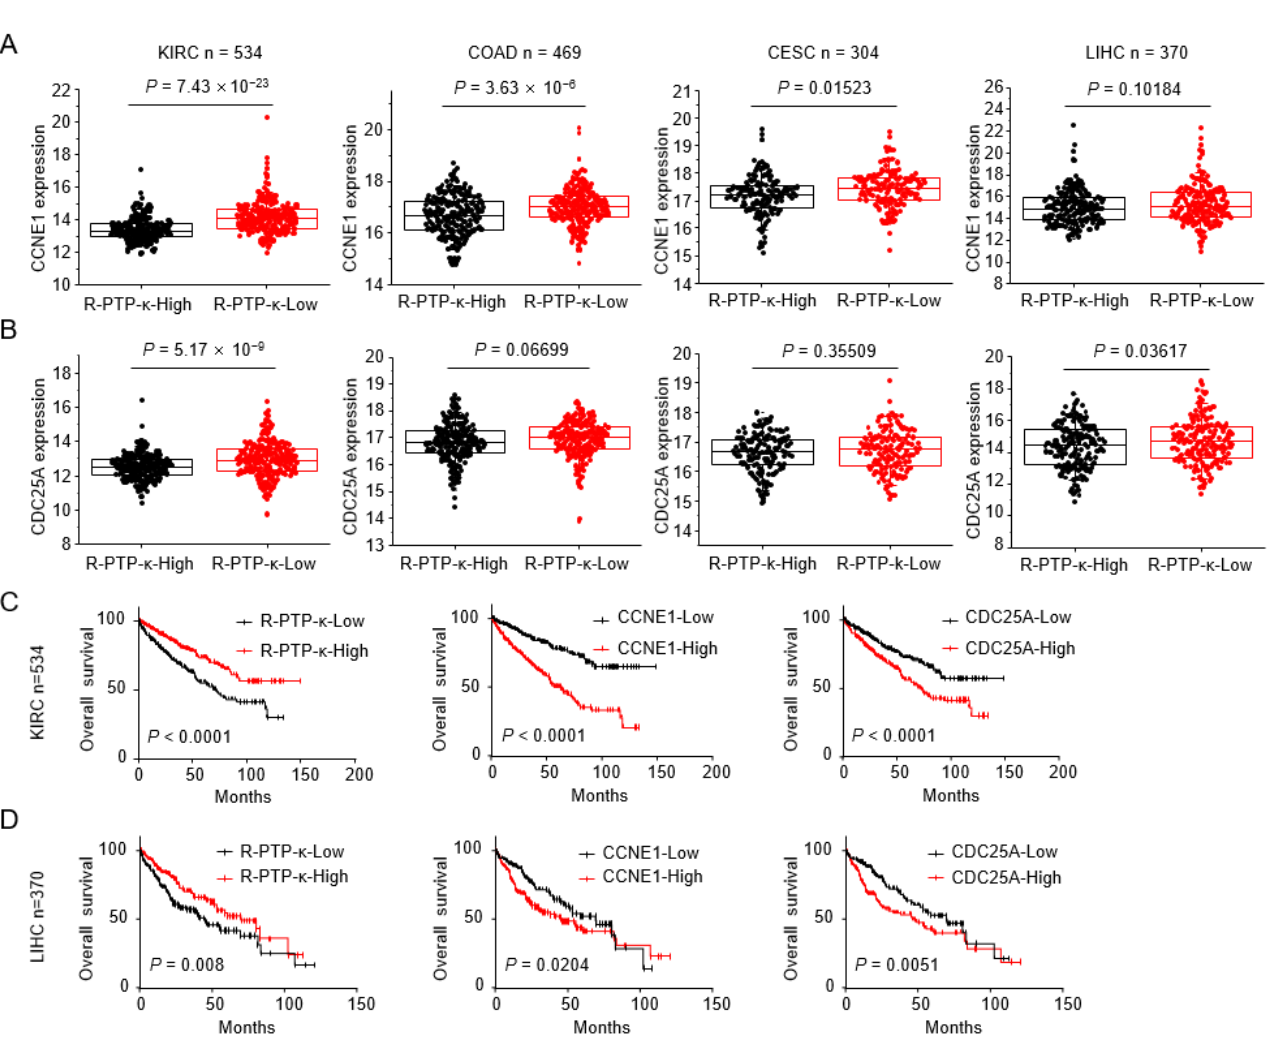
Figure 5. Analysis of expression correlation between R-PTP- κ and two E2F1 target genes, CCNE1 and CDC25A . ( A ) Expression pattern analysis of R-PTP- κ and CCNE1 in the public datasets generated from four different tumor types. ( B ) Expression pattern analysis of R-PTP- κ and CDC25A in the public datasets generated from four different tumor types. ( C ) Kaplan–Meier curve for overall survival in the KIRC cohorts according to relative expression of R-PTP- κ or the two E2F1 target genes. ( D ) Kaplan–Meier curve for overall survival in the LIHC cohorts according to relative expression of R-PTP- κ or the two E2F1 target genes.